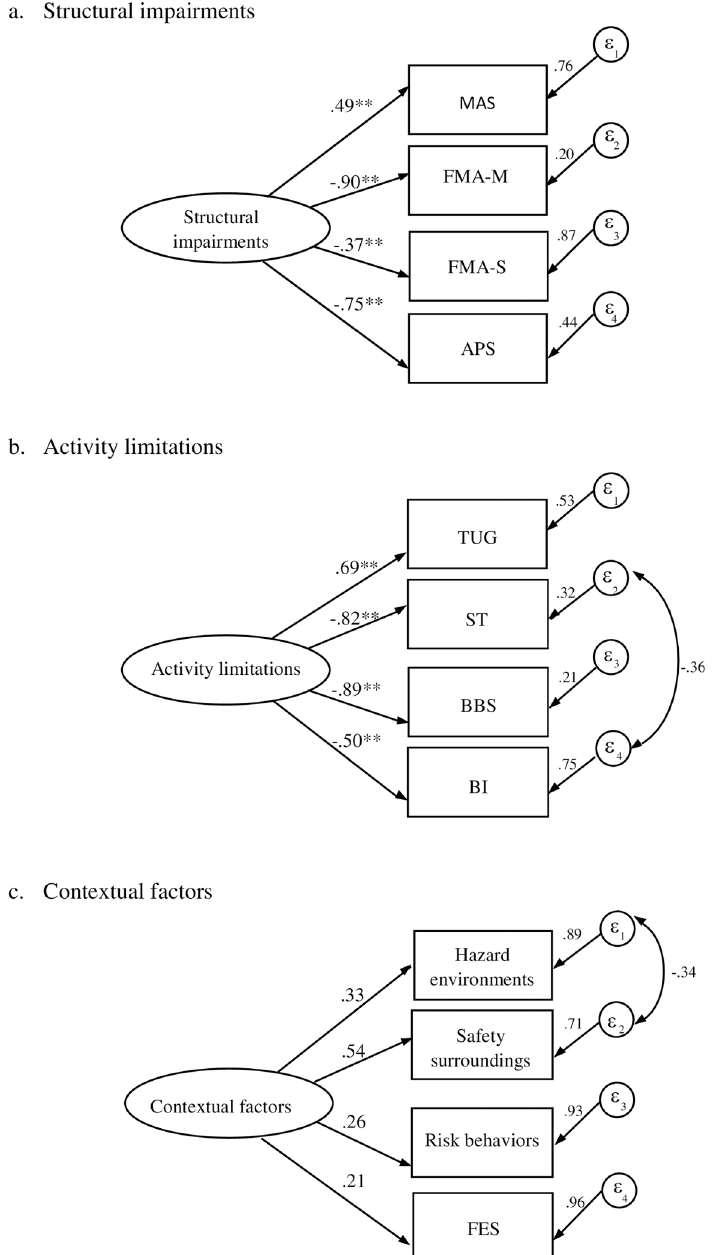
Fig 3. Confirmatory factor analysis of the first order measurement model: a. structural impairments, b. activity limitations, and c. contextual factors. Value of factor loading and amount of measurement error are shown. �� p < 0.001. MAS: modified Ashworth scale; FMA-M: Fugl-Meyer Assessment upper and lower extremity function; FMA-S: Fugl-Meyer Assessment sensory function; APS: Ankle plantarflexor strength; TUG: Timed Up and Go